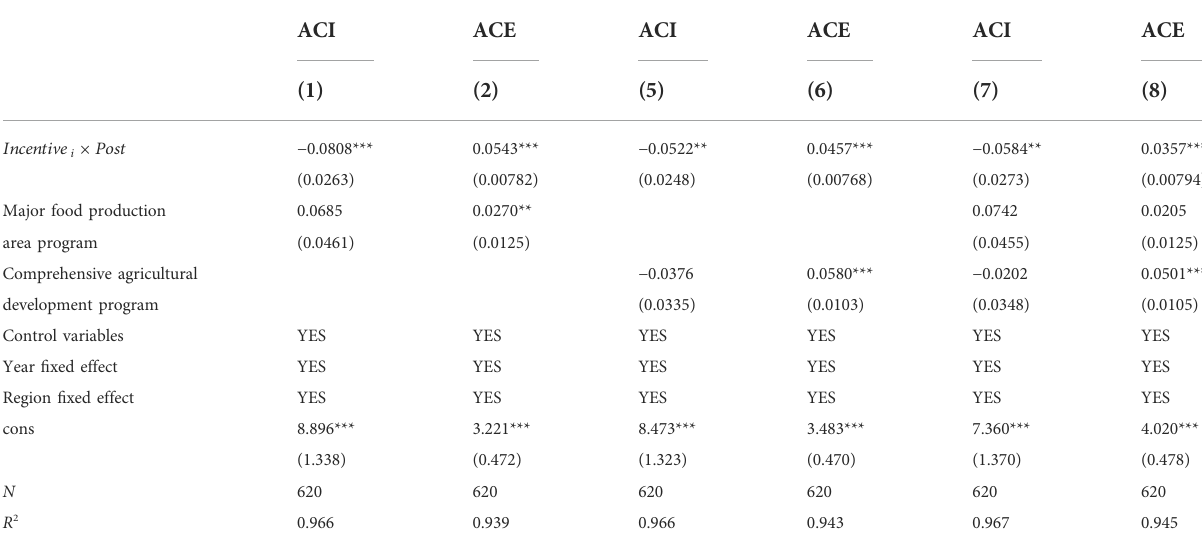
TABLE 5 Excluding contemporaneous policy